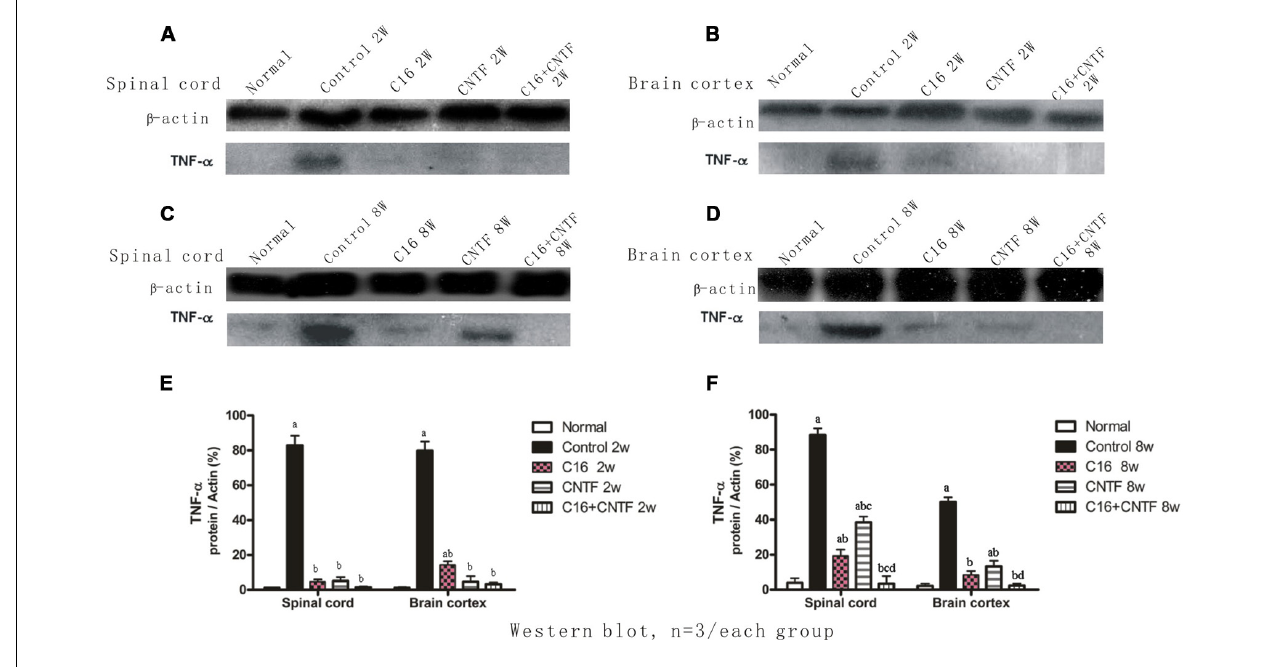
FIGURE 10 |TNF- α expression decreased markedly in both the spinal cord (A,C) and cerebral cortex (B,D) following treatment with CNTF or C16, as compared with the vehicle control, at weeks 2 and 8 post-immunization, as shown byWestern blotting. (E,F) TNF- α expression